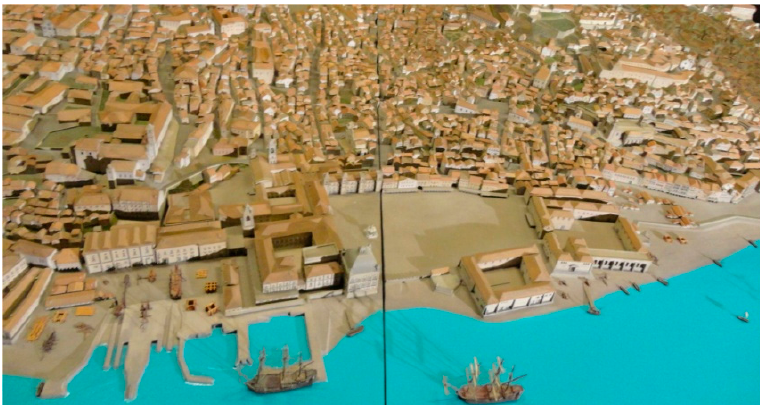
Figure 6. Part of the Lisbon city before the 1755 disaster. The scale model was built during the 1950s and is available at the Lisbon Museum to the public. Photo taken by the second author on 17 September 2018. September